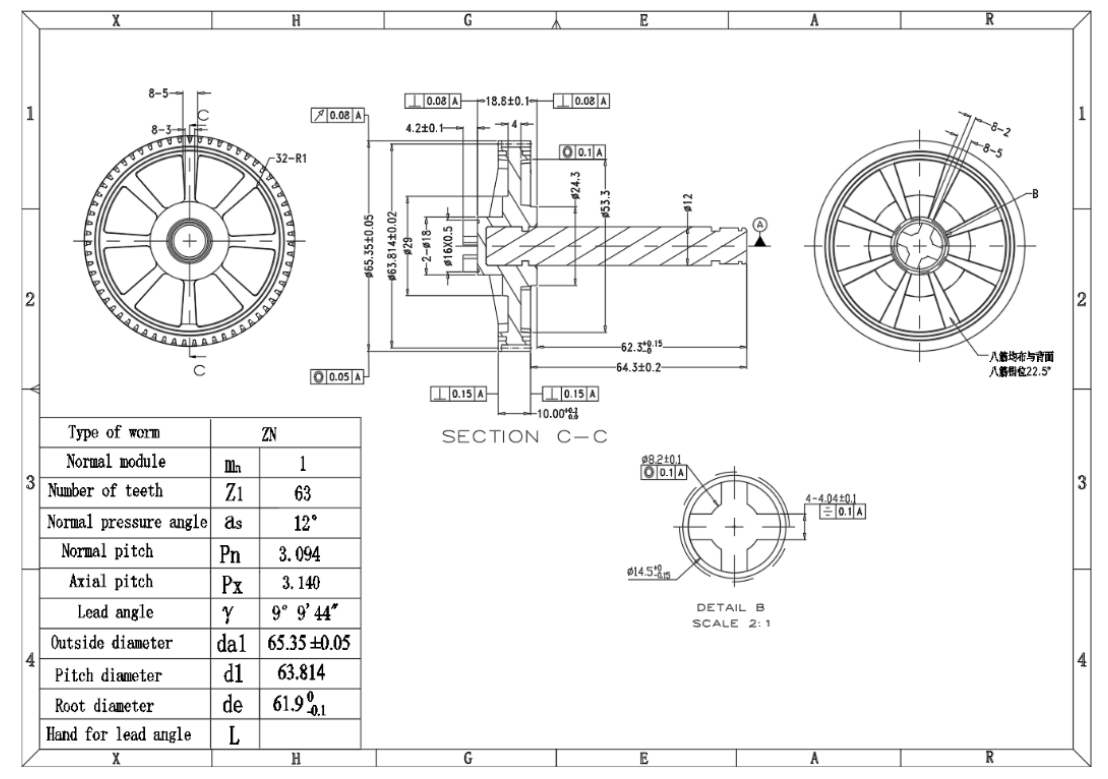
Figure 18. Engineering drawing for the plastic helical gear.